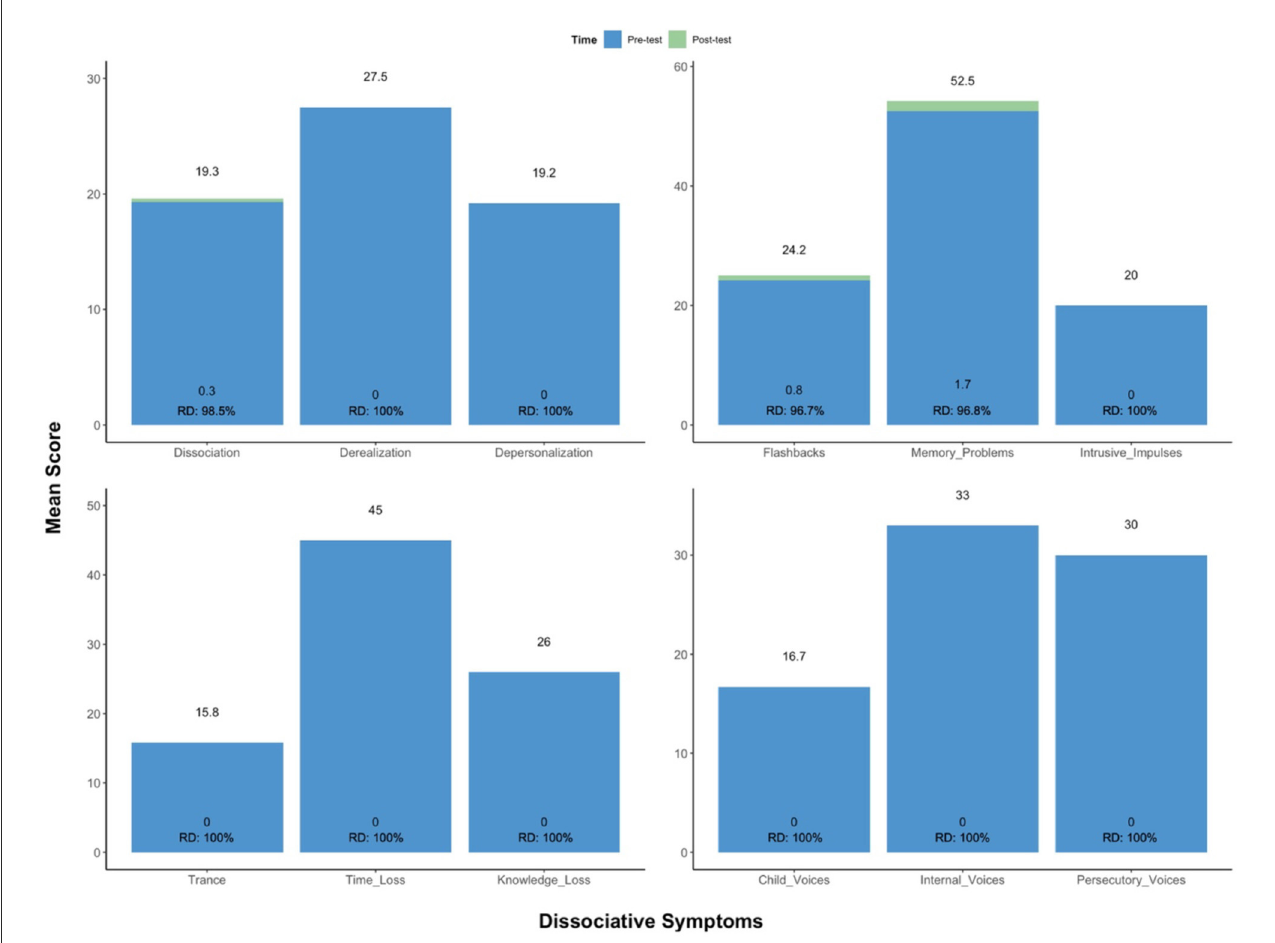
FIGURE3 Change in scoring on the MID. From baseline to post-treatment, following all CAP and CBT sessions, the patient showed a robust improvement in clinically significant dissociative symptoms, no longer meeting criteria for D-PTSD. CAP, cannabis-assisted psychotherapy; D-PTSD, dissociative posttraumatic stress disorder; MID, multidimensional inventory of dissociation; RD,